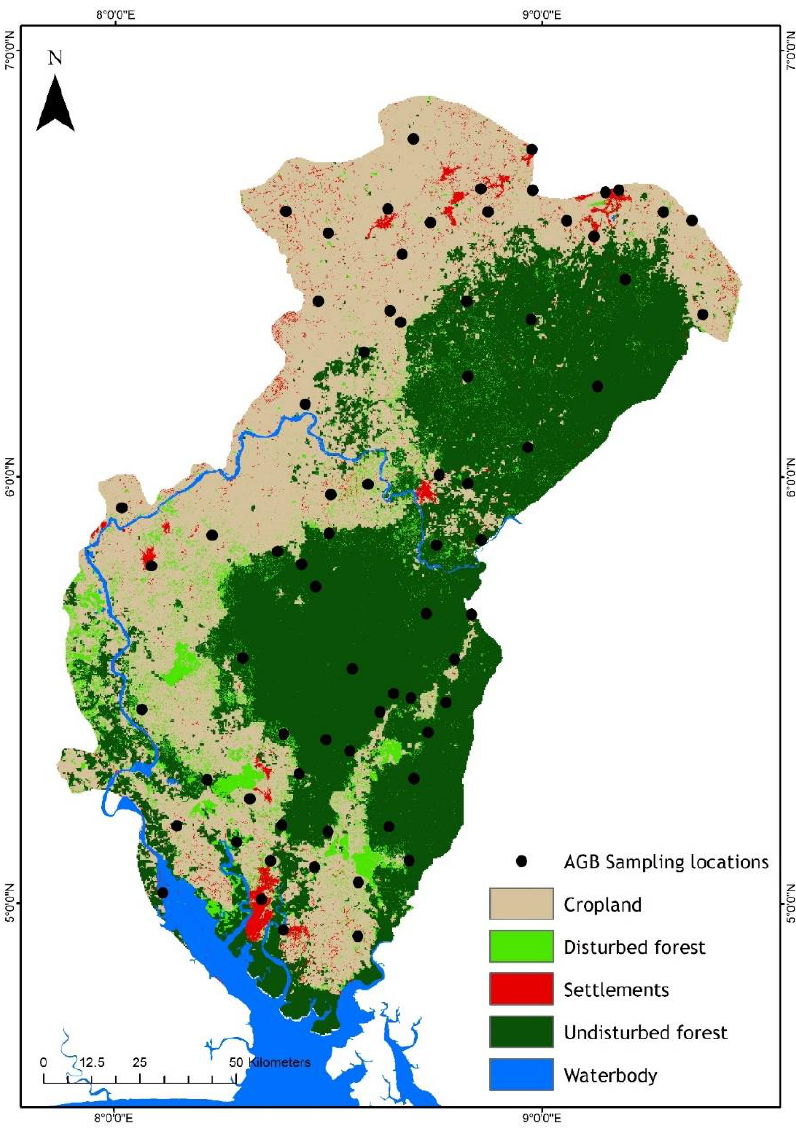
Figure 1. Forest inventory plots throughout the Cross River State were established with Forestry Commission guidance following their land cover classification (Cross River State Forestry Commission Forestry Manual 2019 [48]).